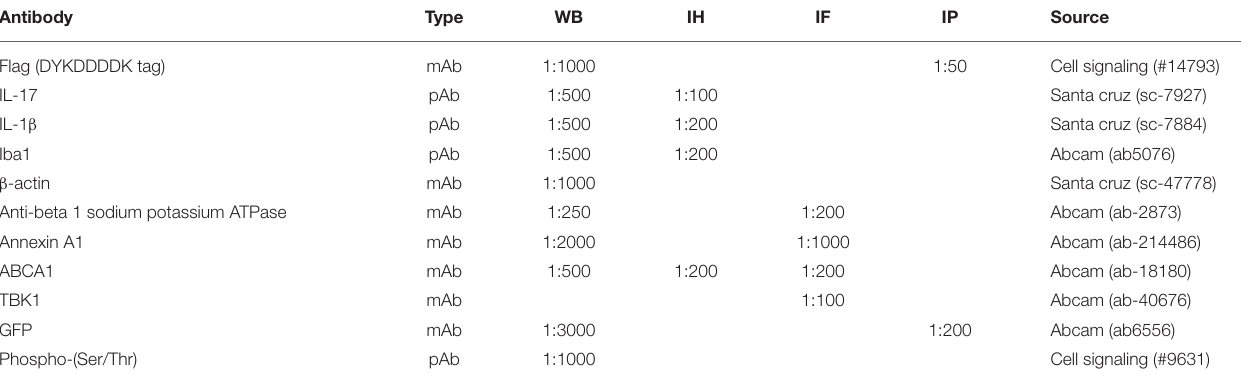
TABLE 1 | Antibodies employed in the study. Antibody Type WB IH IF IP Source Flag (DYKDDDDK